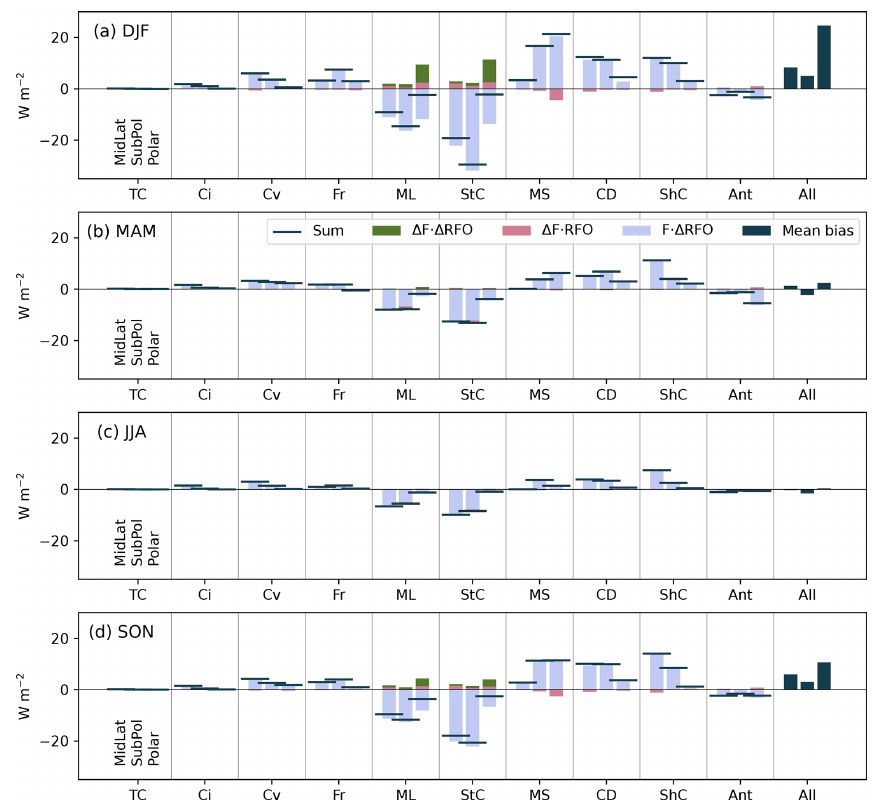
Figure 5. The decomposed mean biases in the SWCRE TOA (Wm − 2 ) for each cloud regime (thin cirrus, TC; cirrus, Ci; convective, Cv; frontal, Fr; mid-level, ML; stratocumulus, StC; marine stratiform, MS; cloud decks, CD; shallow cumulus, ShC; Antarctic, Ant) over the three regions from left to right mid-latitudes, sub-polar and polar, for each season (DJF, a ; MAM, b ; JJA, c ; SON, d ). The sum of the decomposed biases is shown by the horizontal bar, while the terms of the bias decomposition (see Eq. 1) are shown in blue ( F sat r · (cid:49) RFO r ), pink ( (cid:49)F r · RFO sat r ) and green ( (cid:49)F r · (cid:49) RFO r ). On the far right of each plot is the mean radiative bias for each region/season as a reference.